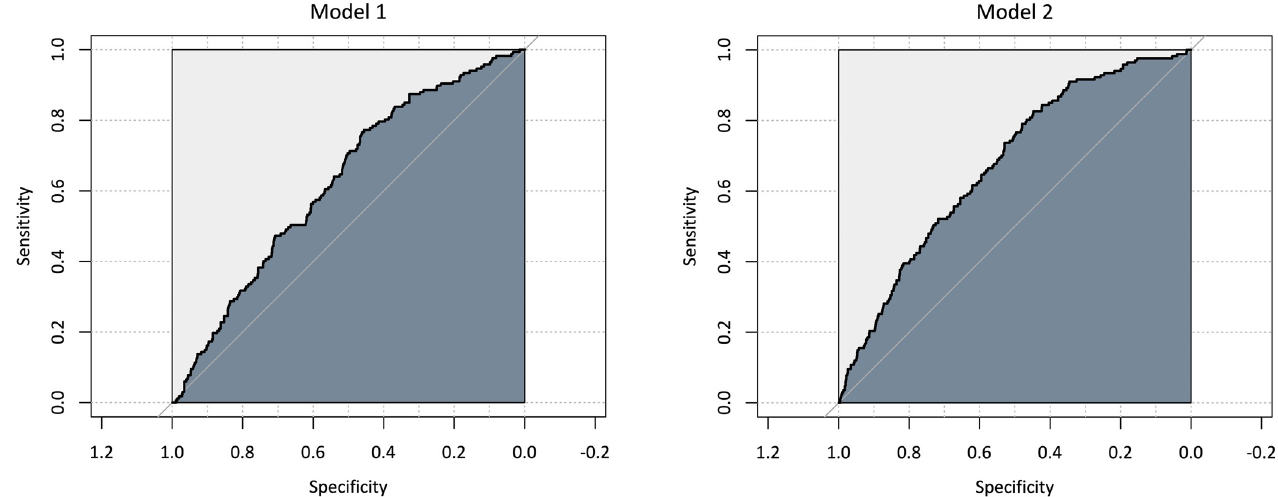
Fig 2. ROC curves for the logistic regression models predicting traffic offense committed (yes/no). Note . Model 1: AUC = .625; Model 2: AUC = .675; AUC = area under curve.